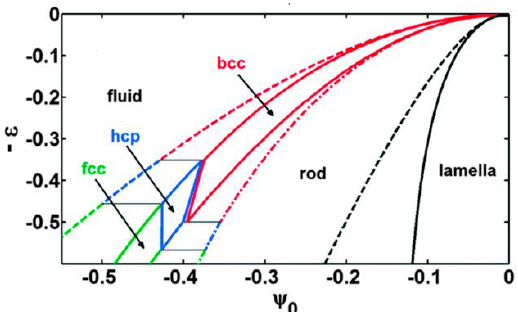
Figure 1. Phase diagram of the single-mode phase-field crystal model in 3D. (Reproduced with permission from Reference [30].) Besides the 3D crystalline phases, see the presence of 2D periodic phases such as the triangular rod phase and the lamellar phase.